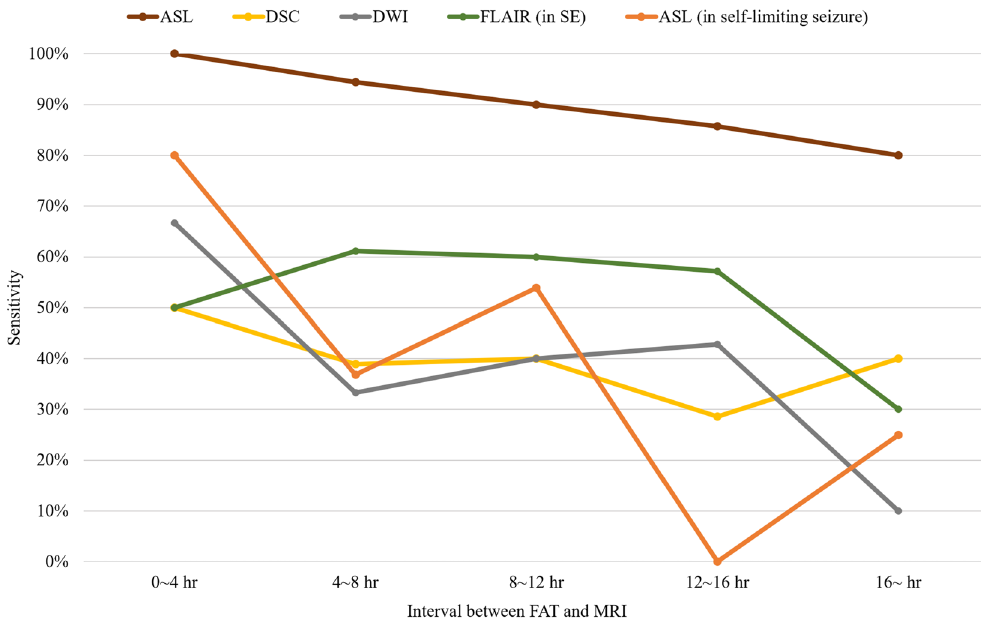
Figure 1. Comparison of the sensitivities of MR sequences according to the interval between the first abnormal time and MRI acquisition. Generally, the sensitivity of each sequence decreases over time. ASL has the highest sensitivity for detecting status epilepticus in all time intervals compared to other sequences. The tendency of decreasing sensitivity with time is also seen for self-limiting seizures. For self-limiting seizures, the interval between the last seizure and MRI acquisition was used. ASL arterial spin labeling, DSC dynamic susceptibility contrast, DWI diffusion-weighted imaging, FAT first abnormal time, FLAIR fluid-attenuated inversion recovery, MR magnetic resonance, MRI magnetic resonance imaging, SE status epilepticus.